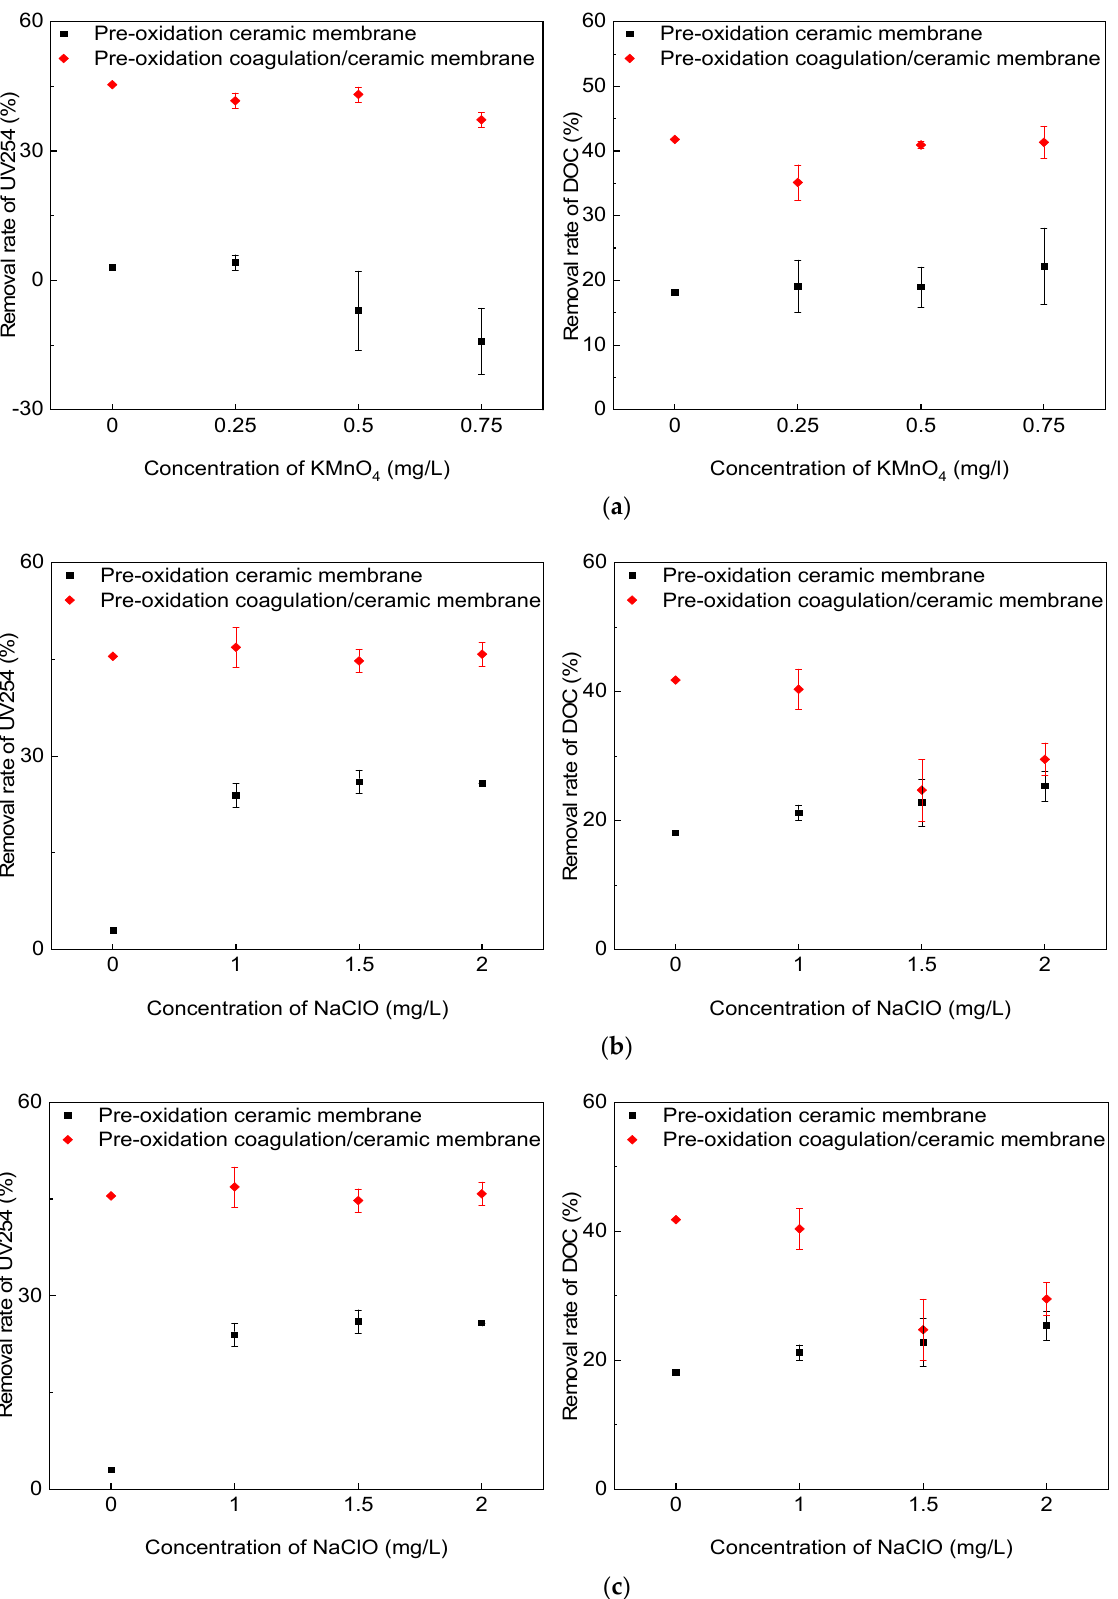
254 and DOC: ( a ) KMnO 4 ; ( b ) NaClO; ( c ) O 3